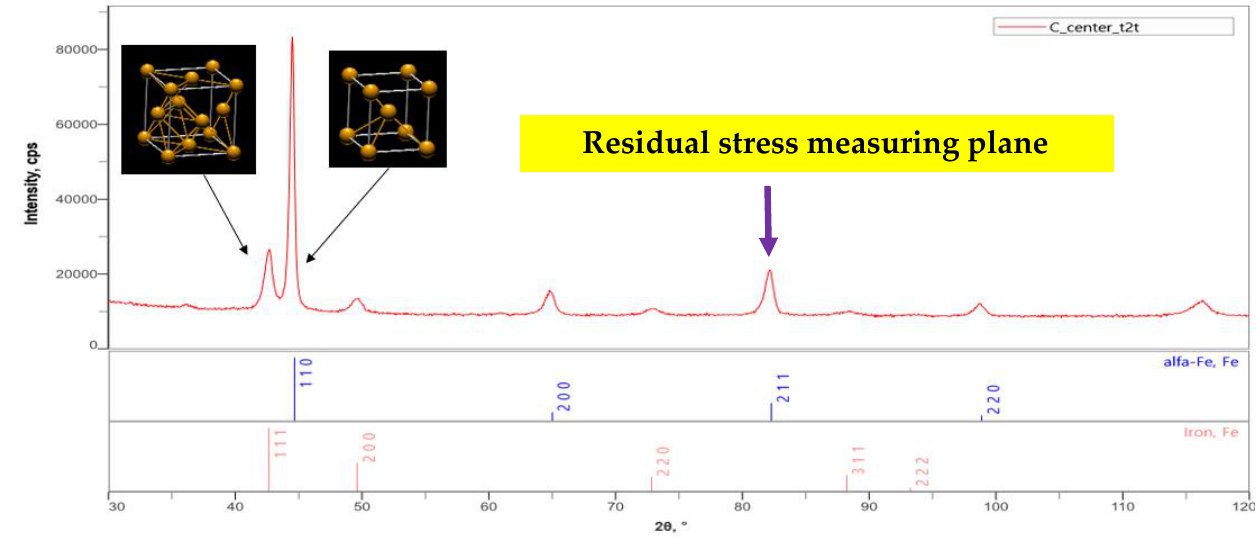
Figure 11. X-ray diffraction patterns of the normal welded specimen.